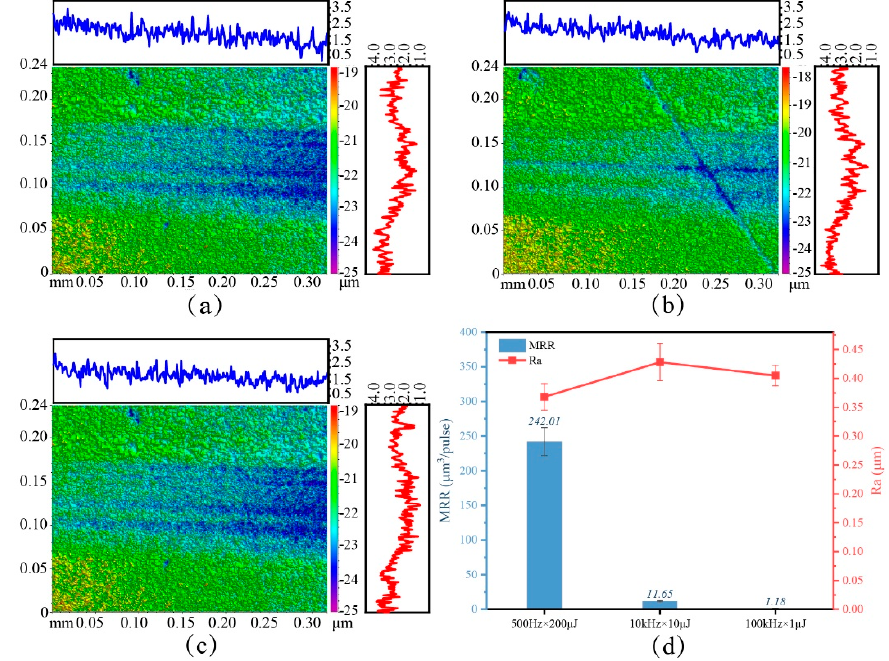
Figure 10. WL interferometer reconstructed topographies of fs laser-irradiated regions under ( a ) 500 Hz × 200 µ J, ( b )10 kHz × 10 µ J, and ( c )100 kHz × 1 µ J. ( d ) Surface roughness Ra and MRR measured under the given conditions.